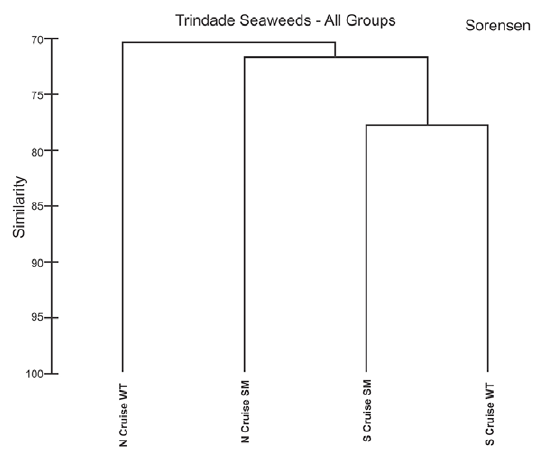
Fig. 6. – Sorensen similarity index considering macroalgae taxon richness (Rhodophyta, Phaeophyceae and Chlorophyta), comparing faces (N, north; S, south) and cruises (WT, winter; SM, summer) from Trindade Island.